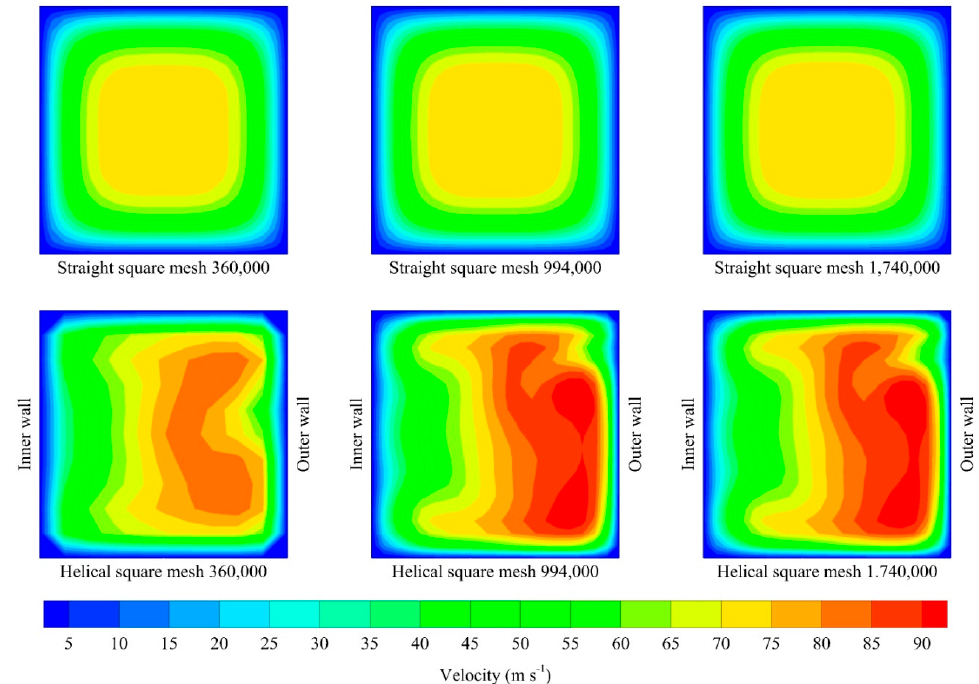
Figure 2. Axial velocity profile (contour, m s − 1 ) of flow in straight and helical squares for various mesh.